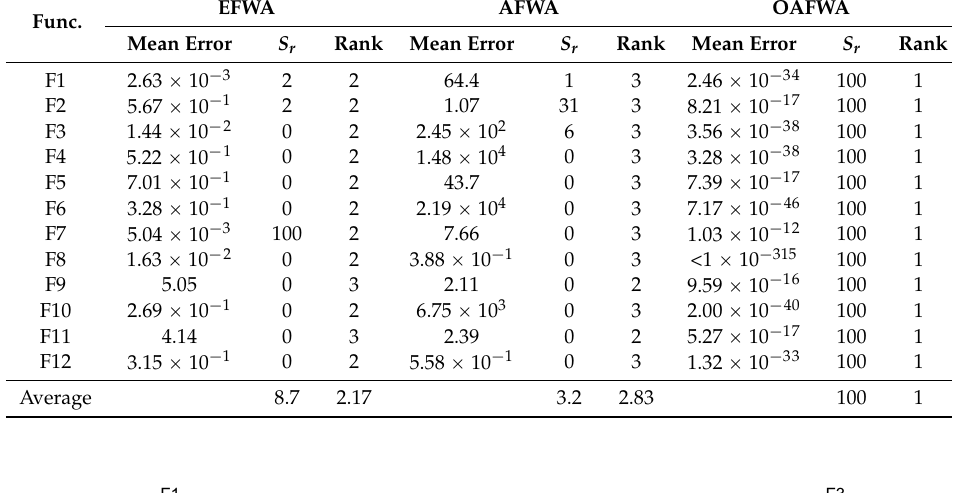
Table 7. Success rates and mean error ranks for three FWA-based algorithms. Func.